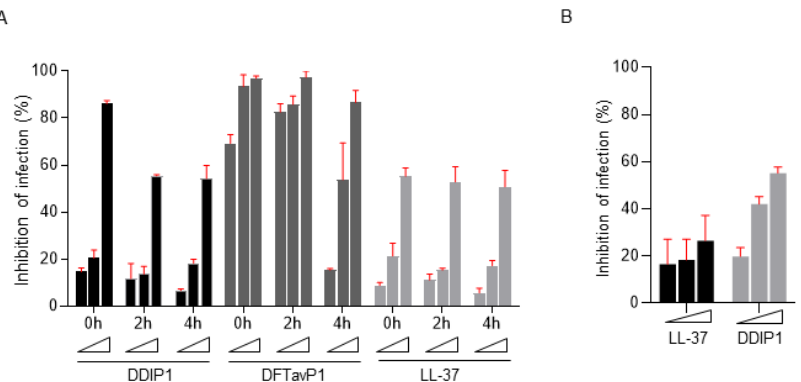
Figure 5. Designed AMPs inhibited EBOV cell entry and SARS-CoV-2 infection. ( A ) AMPs targeted pseudo-EBOV (VSV-eGP) at the early stage of infection. Vero cells were treated with individual AMPs (at 2.5, 5, or 10 μM) at the same time with VSV-eGP (0 h), or at 2 or 4 h after VSV-eGP infection. Vero cells were harvested for flow cytometry analysis of GFP levels at 24 h post infection. ( B ) DDIP1 inhibited SARS-CoV-2 infection. Vero cells were pretreated with individual AMPs (at 2.5, 5, or 10 μM) for 2 h before SARS-CoV-2 viruses were added. After 24 h of culture, Vero cells were harvested for immunofluorescence staining to access infection activity.